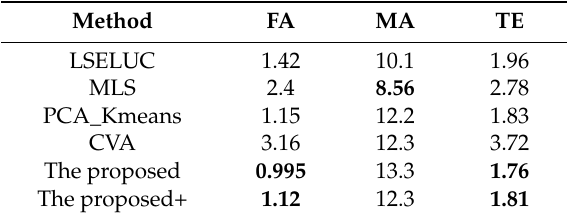
Table 4. Comparison between other methods and the proposed approach for the Sardinia data.